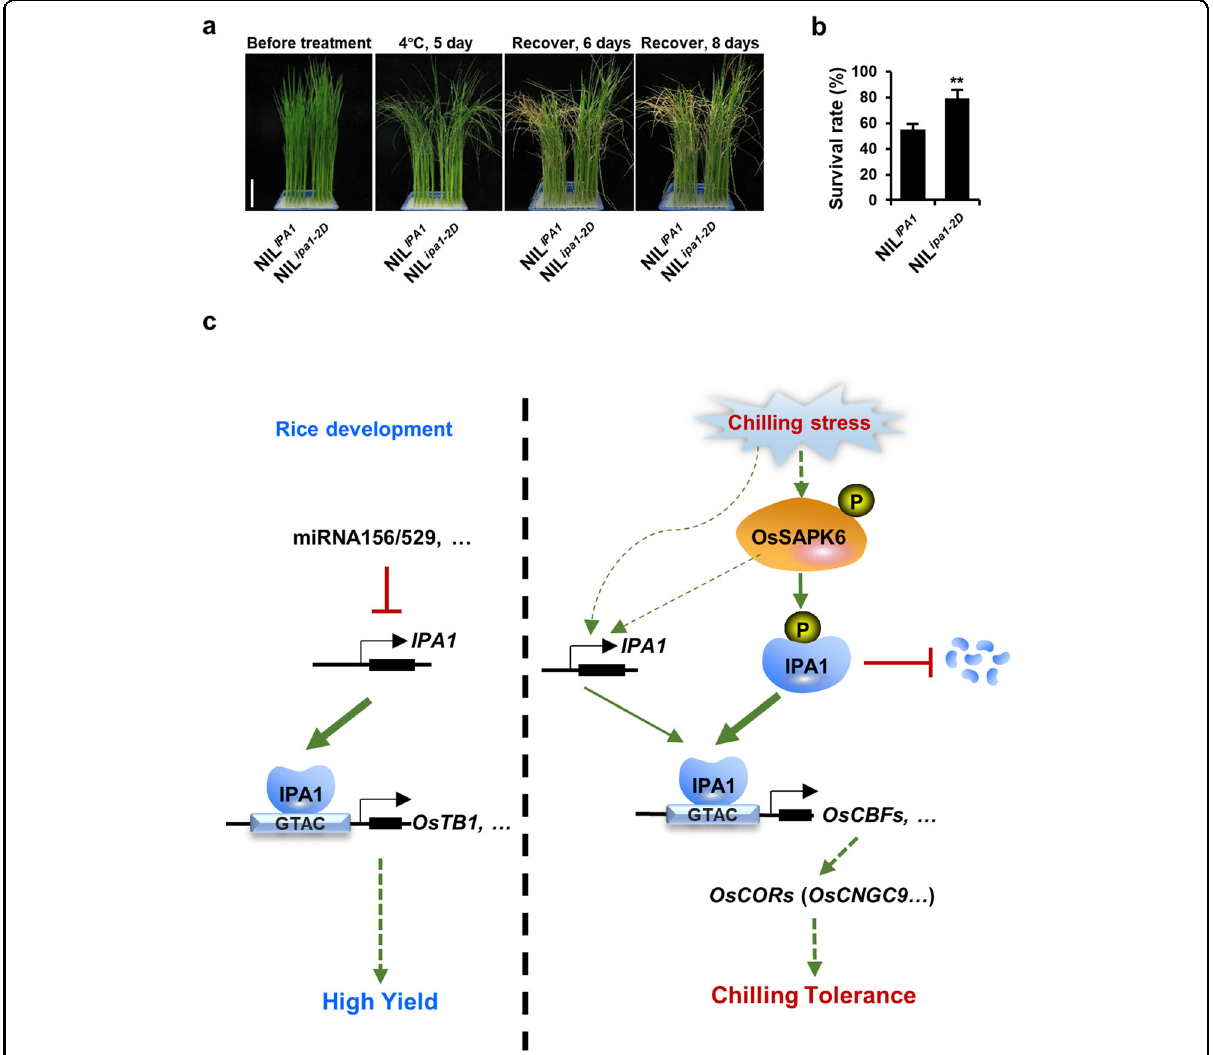
Fig. 8 Natural allele ipa1-2D enhances seedling chilling tolerance. a Plant morphologies of 2-week-old NIL IPA1 and NIL ipa1-2D seedlings before treatment, after 4 °C treatment for 5 days and subsequent recovery for 6 or 8 days. b Survival rates of NIL IPA1 and NIL ipa1-2D after 4 °C treatment as shown in a . Values are means ± SD ( n = 3 biological replicates), and the asterisks indicate signi fi cant differences compared with the NIL IPA1 (** P < 0.01, Student ’ s t- test). c Proposed model of OsSAPK6-IPA1-OsCBFs signaling cascade under chilling stress in rice. Under chilling stress, OsSAPK6 phosphorylates IPA1 on Ser201 and Ser213, leading to an accumulation of IPA1 proteins, and IPA1 in turn up-regulates OsCBFs expression by binding to GTAC motifs on the OsCBFs promoter, which then activates the downstream COR genes such as OsCNGC9 to confer chilling tolerance in